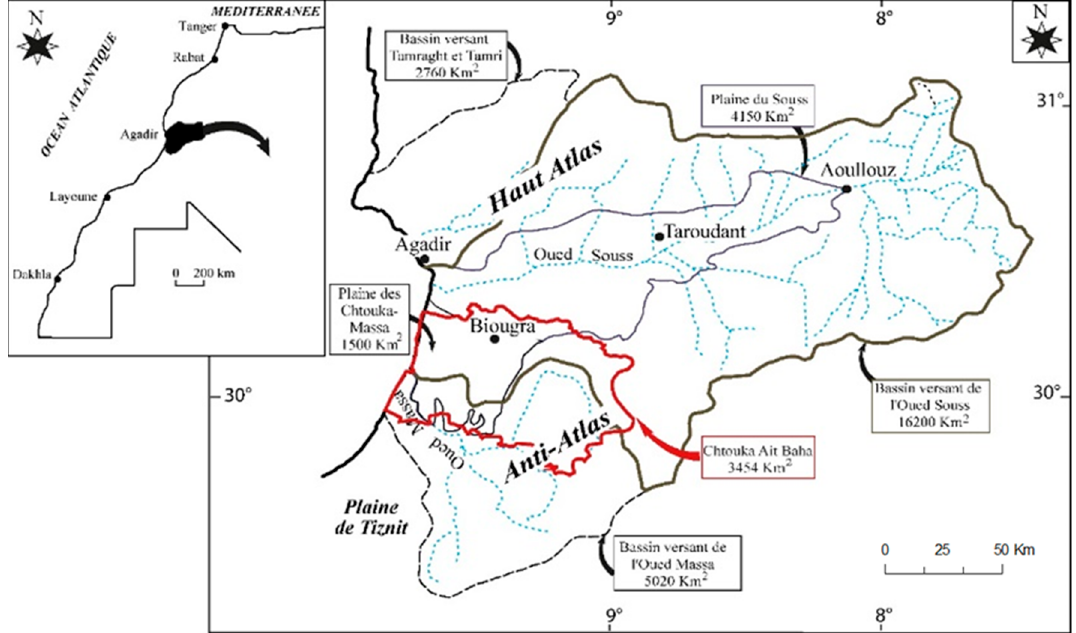
Figure 1. Location and elevation of the study area (Chtouka Ait Baha).